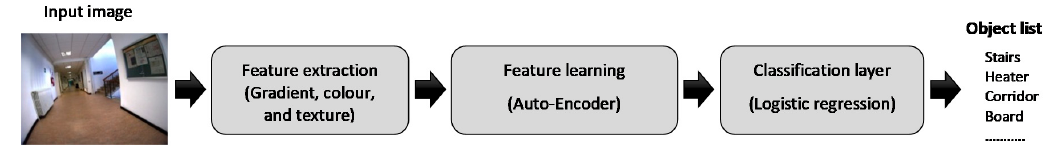
Figure 2. Pipeline of the feature learning-based image multilabeling scheme.